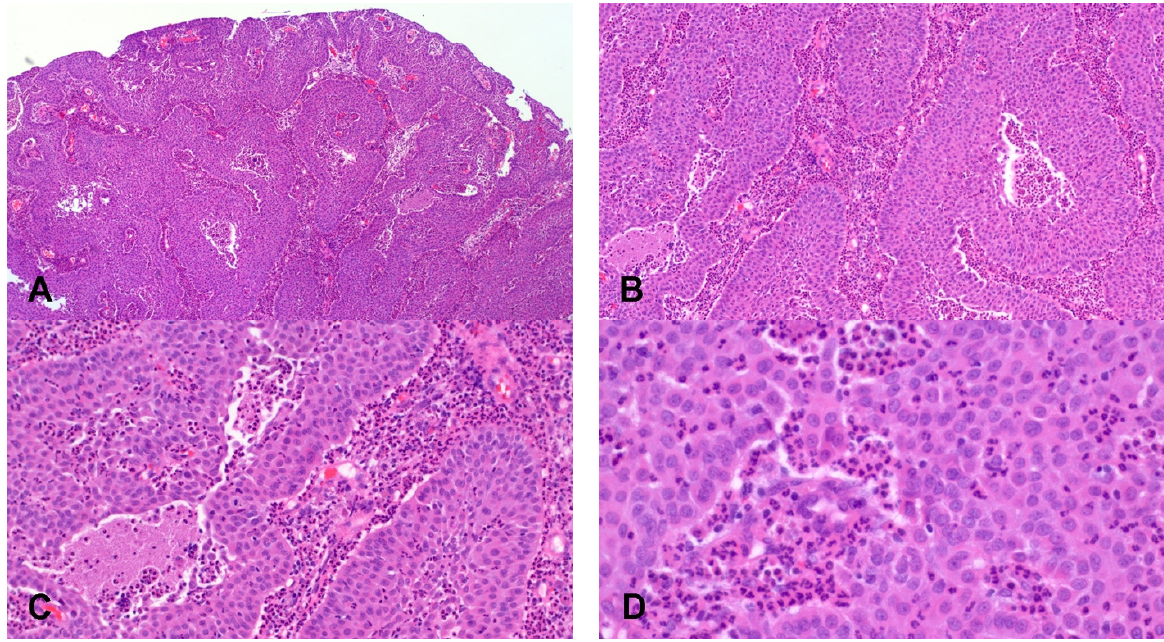
Figure 2. Sinonasal DEK-AFF2 fusion associated squamous carcinoma. The tumor shows an in- verted growth pattern (( A ), Hematoxylin and eosin, 5× Objective original magnification) and consists of nests and interconnecting trabeculae with no evidence of keratinization ( B ), (Hematoxylin and eosin, 10× Objective original magnification). Neutrophilic infiltrates are present both in the stroma and within the tumor (( C ), Hematoxylin and eosin, 20× Objective original magnification). Tumor cells present a bland uniform appearance with no overt cytologic atypia (( D ), Hematoxylin and eosin, 40× Objective original magnification).